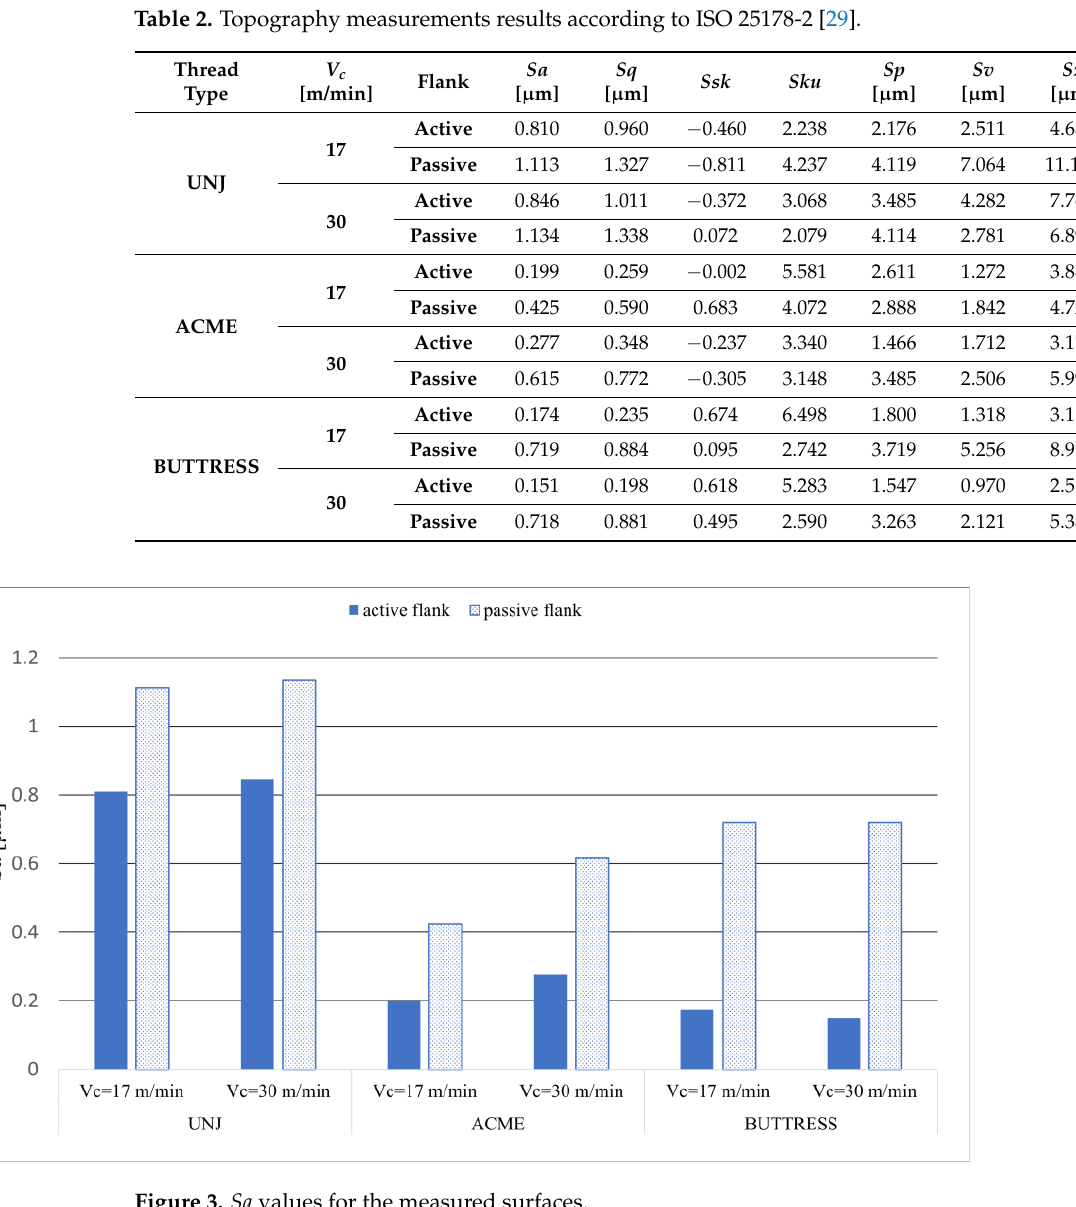
Figure 4. Sq values for the measured surfaces. Analysing the data shown in Figures 3 and 4, we can see a correlation between them. This is of course natural, as these parameters are related to each other due to their mathe- matical description. On each thread, the obtained values of Sa and Sq on the passive side were higher than those on the active one. This may be a result arising from the direction of the chip flow and its difficult evacuation. Additionally, on this flank, greater cutting forces occurred due to the thrust of the insert. Regarding the influence of the cutting speed, no significant differences in the obtain results of Sa and Sq were detected. For the UNJ and ACME threads, the increase of the cutting speed resulted in a slight growth of the parameter values; for the BUTTRESS ones, this resulted in a slight drop. It is possible that the change v c from 17 m/min to 30 m/min was too small and, in the case of further increase, the differences would be more noticeable. It was noticed that, in the threads with triangular outline, the average values of the spatial roughness were higher than those in the trapezoidal threads. A maximum value of Sa = 1.134 µm (Figure 5a) was obtained for the passive flank of the UNJ thread and v c = 30 m/min and the minimum Sa = 0.151 µm (Figure 5b) for the active surface of the BUTTRESS thread, with v c = 30 m/min. The strategy